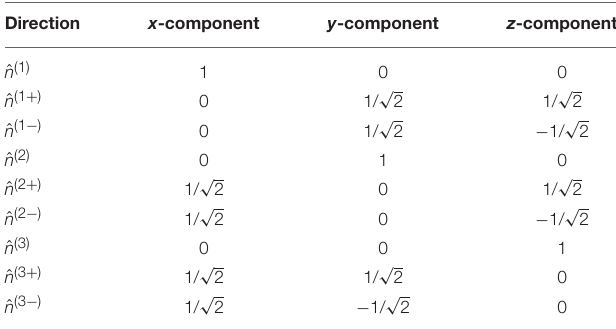
TABLE 1 | The nine directions in the compact notation (leftmost column) used in the manuscript and stated as normalized vectors.